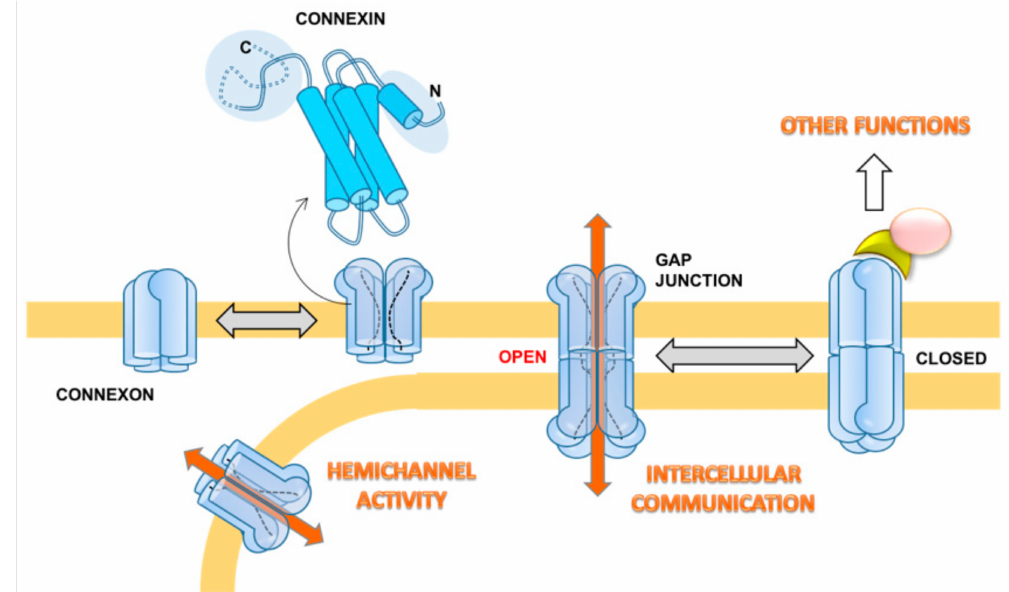
Figure 1. Schematic overview of the structural and functional features of connexins (Cxs). The folding of Cx is shown as inferred from the crystallographic structure of the Cx26 gap junction (GJ). The exameric connexons are shown in closed and open conformation, leading in the latter case to the hemichannel activity and GJ intercellular communication (GJIC). Non-GJIC or hemichannel related function of Cxs is also shown as resulting from interaction with cytosolic e ff